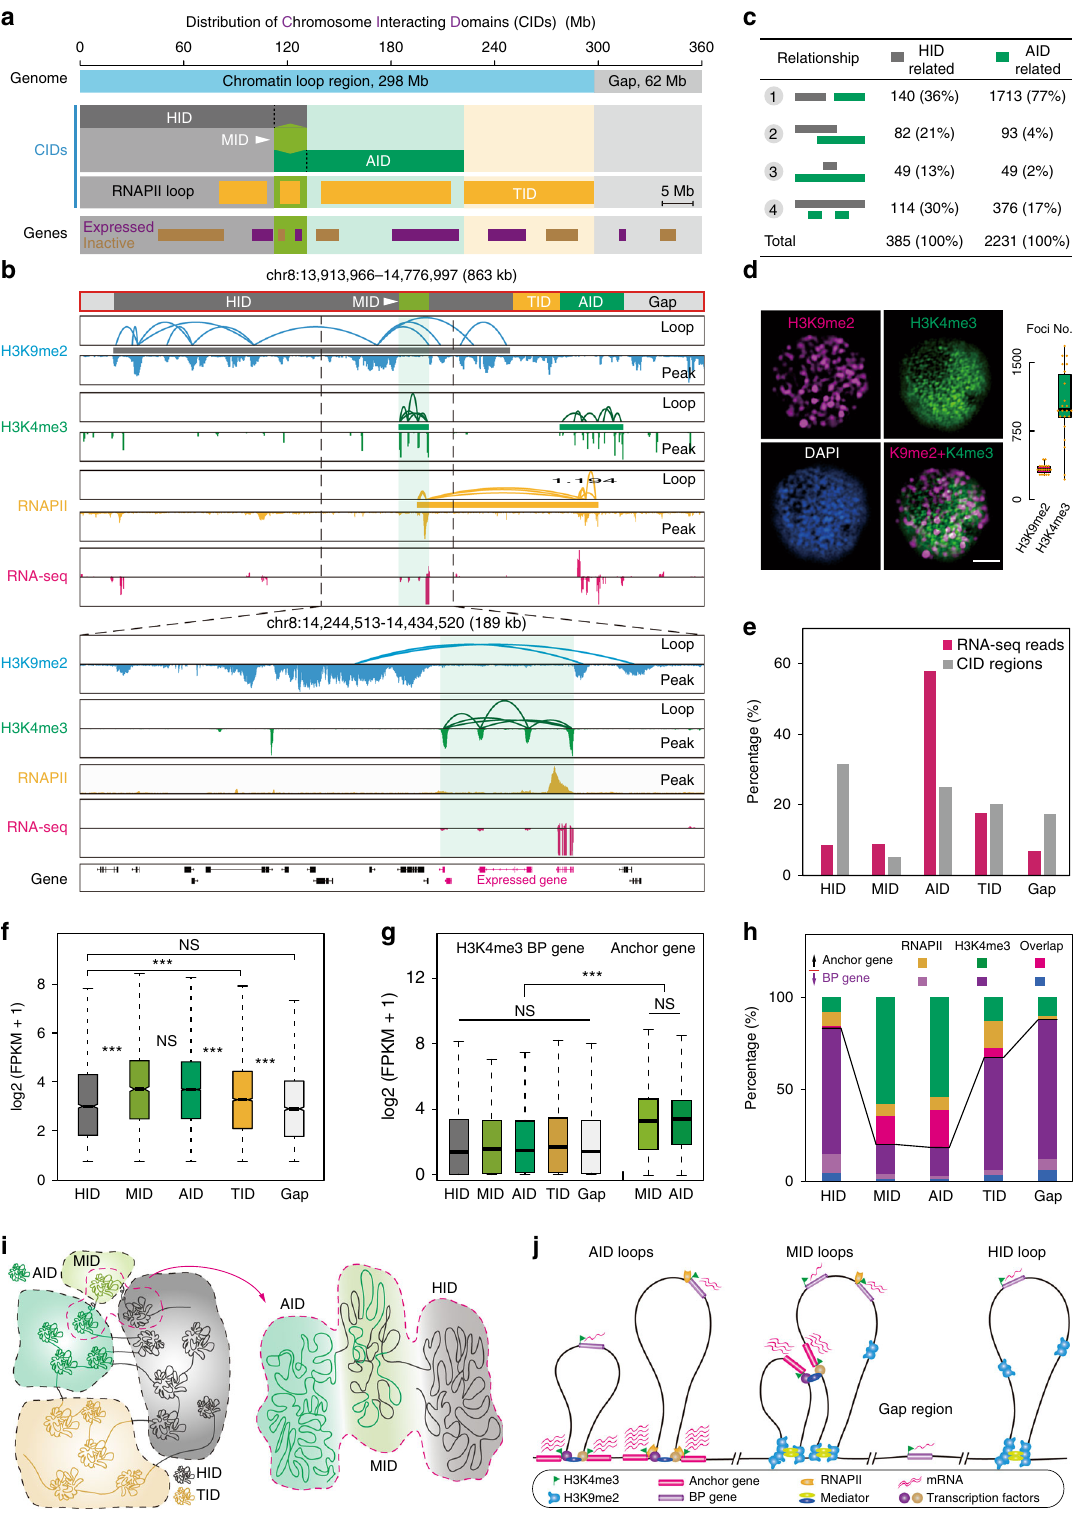
fl uorescence signals. Strikingly, the majority (77%) of AID-related segments were isolated from HID-related segments (Fig. 4c). The overlapping regions accounted for 5% (19 Mb) of the rice genome and were named as H3K9me2 and H3K4me3 MIDs (Fig. 4a), consistent with the small proportion of H3K9me2 and H3K4me3 overlapping immunostaining speckles (orange) in the rice nucleus (Fig. 4d). Thus, the modules based on three types of